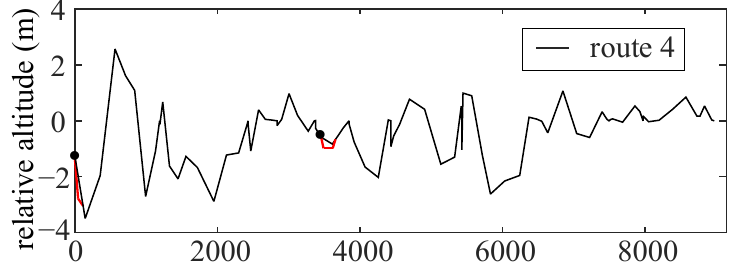
Figure 10. The simulation result of route 4. Overall, the prediction deviation of the slope is not